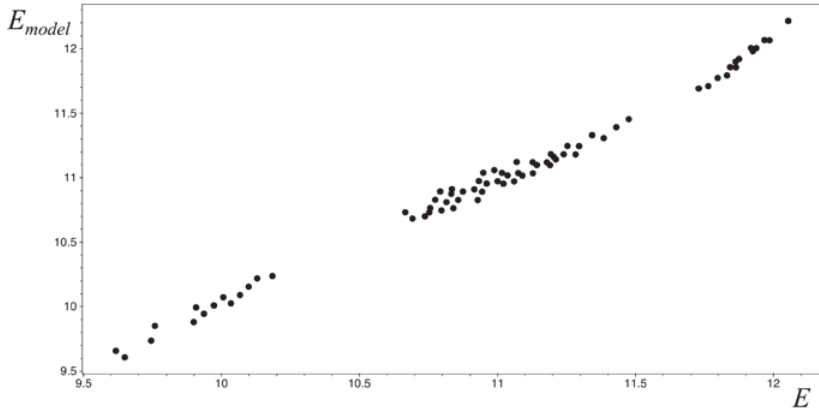
Figure 6. The model given in (12) versus the graph energy in the case of